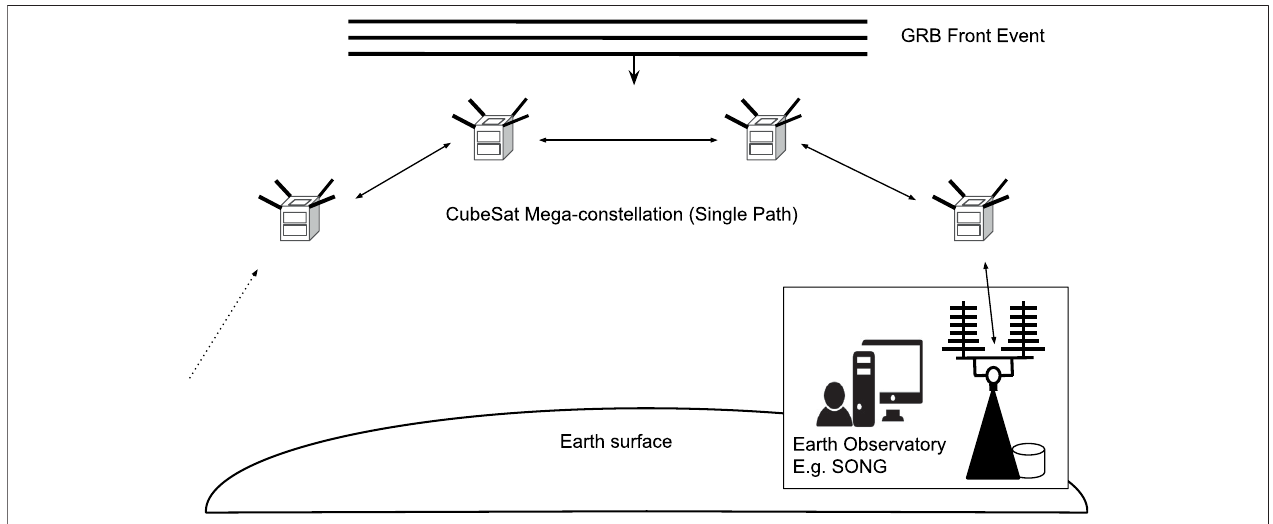
FIGURE 2 | IMPACT system overview of one possible data transmission path in a CubeSat mega-constellation detecting a GRB front from above. The path consists of various detecting and data forwarding CubeSats to an Earth observatory for analysis, for example, a ground station in SONG.